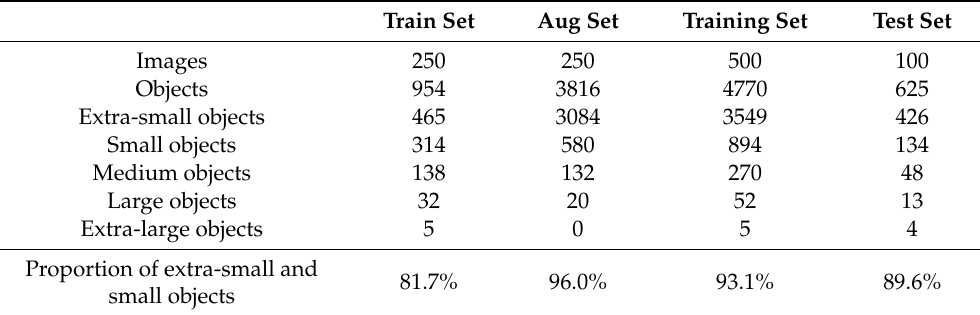
Table 2. Correspondence size in 300 × 300 images and 75 × 75 feature maps of objects.